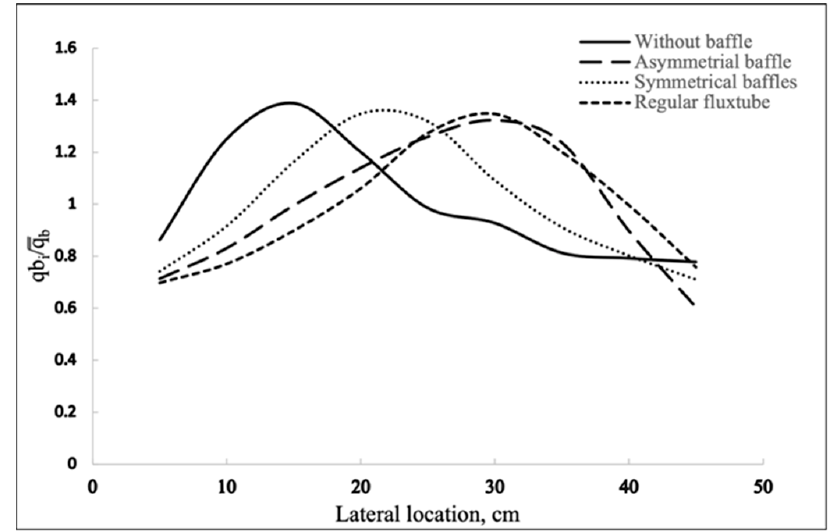
Figure 4. Lateral gas bubble distributions at the injection level with and without baffle and regular fluxtube under the superficial gas velocity of 0.4 m/s using the even inlet configuration.